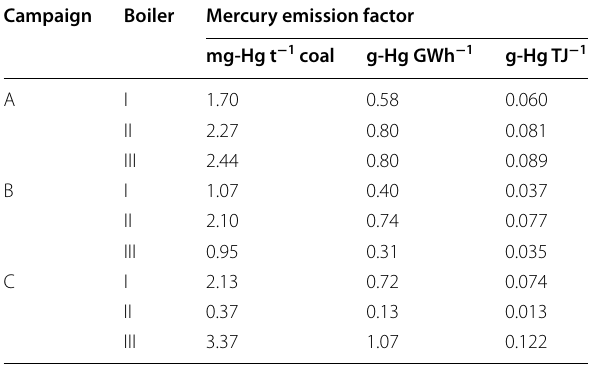
Table 4 The relative enrichment factors of mercury in bottom ash and fly ash